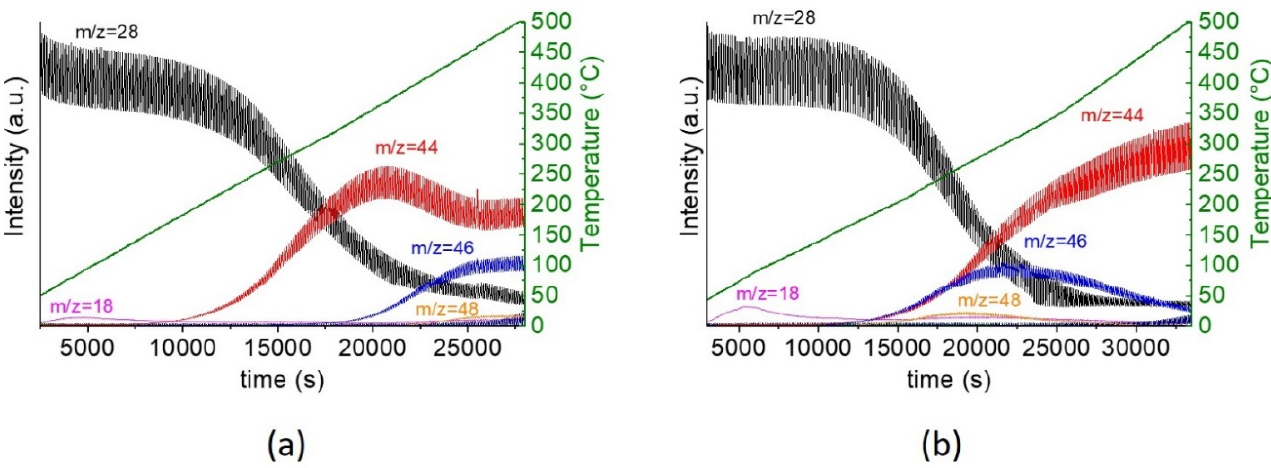
Figure 5. Pulsed CO oxidation on 18 O-exchanged CFO_eaf ( a ) and SFO_eaf ( b ). The mass signals correspond to the following gases: m / z = 18: water or surface oxygen, m / z = 28: CO, m / z = 44: C 16 O 16 O, m / z = 46: C 18 O 16 O and m / z = 48: C 18 O 18 O. For clarity, the O 2 signal m / z = 32 is not shown. The experiment is carried out under oxidative conditions, so the m / z =32 signal is stable.